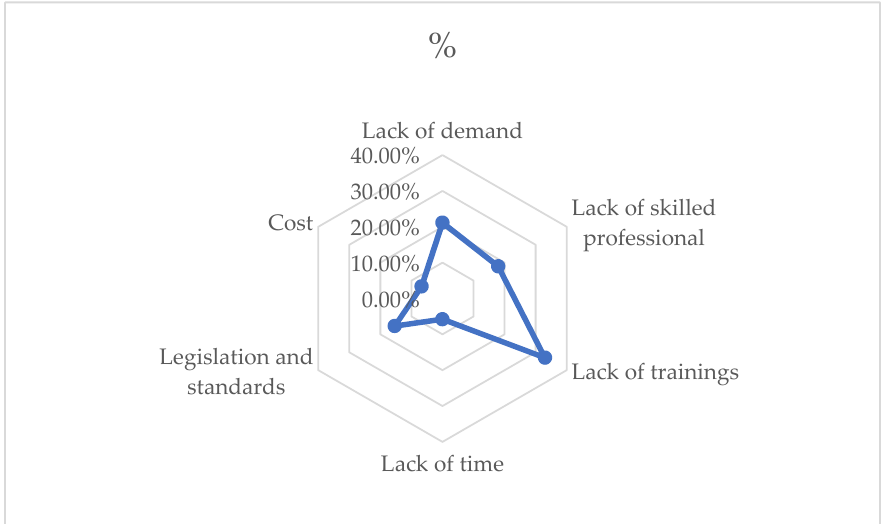
Figure 5. Attitude toward using BIM. ( a ) The intention to use BIM in the near future; ( b ) the exist- ence of request for BIM.